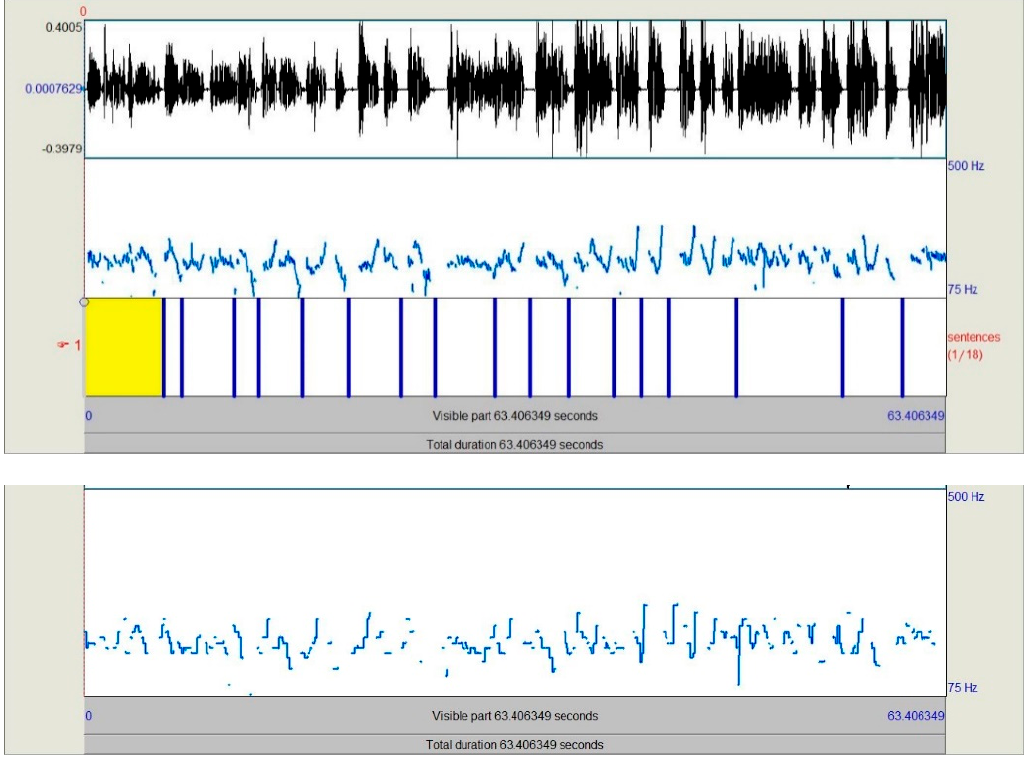
Figure A1. Stimulus 1—Pitch structure. Table A1. Stimulus 1—Transcription.